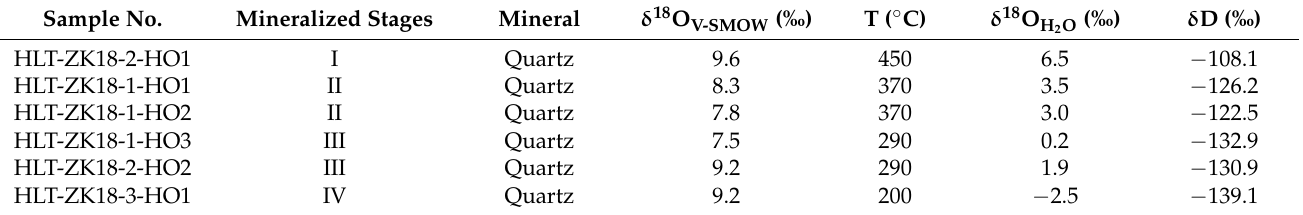
Table 2. H and O isotope data of quartz samples from the Huoluotai Cu (Mo) deposit.